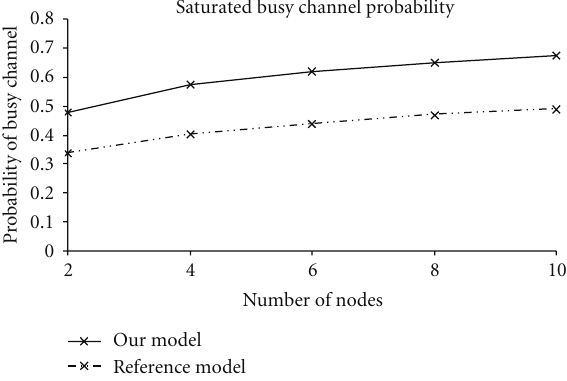
Figure 12: Probability of busy channel, basic mode.